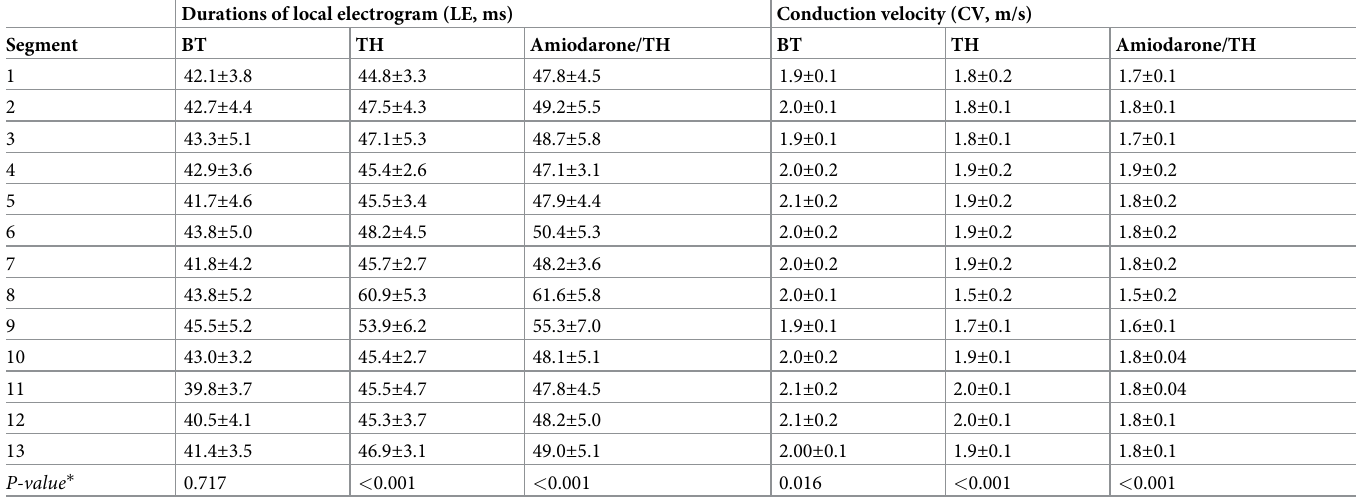
Table 2. Electrophysiological parameters in different epicardial segments during sinus rhythm. Durations of local electrogram (LE,